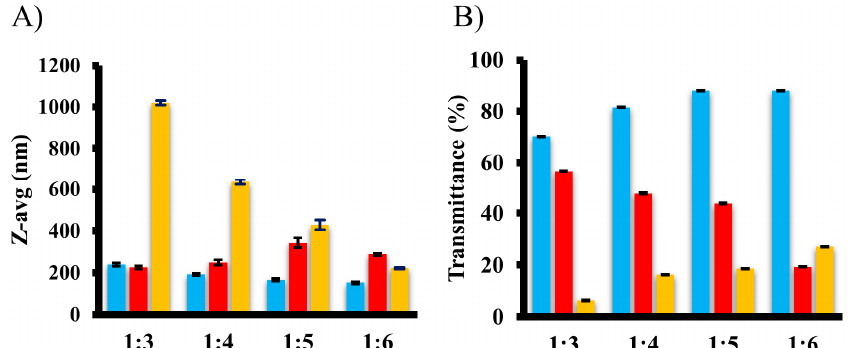
Figure 2. Emulsification ability of Kolliphor ® EL (blue), Labrafil ® M 1944 CS (red), and Labrasol ® (yellow) with Peceol ® at different w / w ratios characterized by droplet size ( A ) and transmittance ( B ) analysis. (Mean ± SD; n = 3).